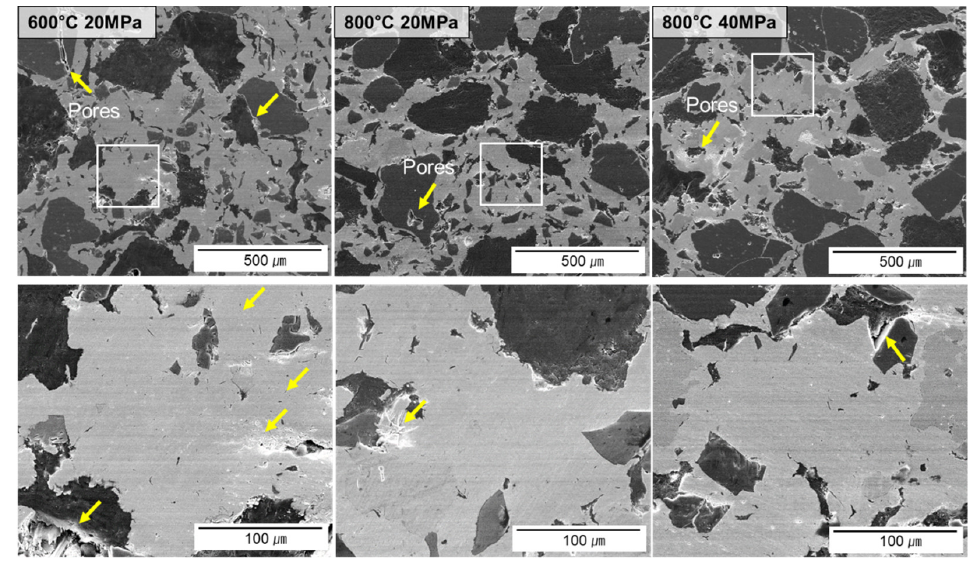
Figure 2. Scanning electron microscopy (SEM) images of surface microstructures of 600-20, 800-20, and 800-40 samples.